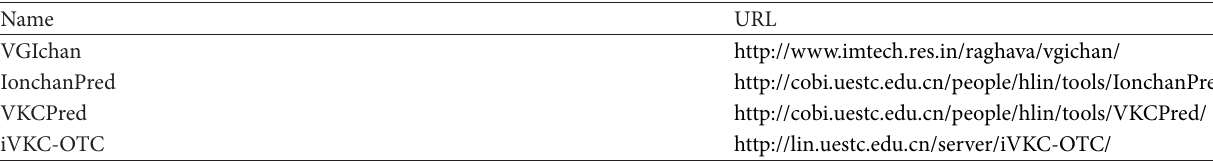
Table 3: Summary of the ion channel prediction